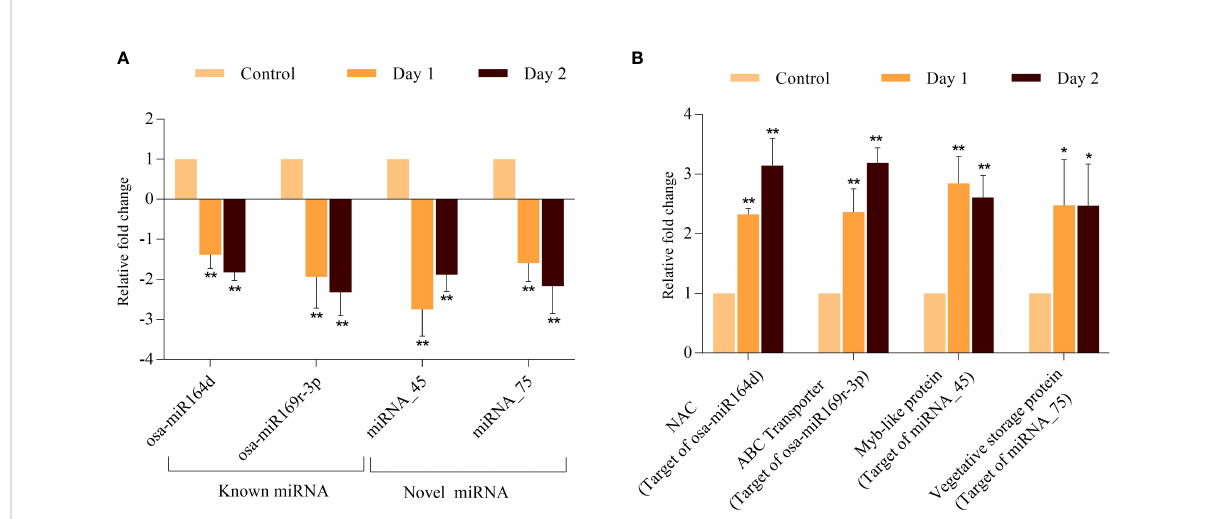
FIGURE 7 Validation of expression pro fi le of miRNAs and their predicted target genes during coleoptile senescence in rice. Expression analysis of selected miRNAs (A) and one of their predicted targets genes (B) using qPCR. For normalization of real-time PCR results, eEF-1 a was used as internal control. Three biological replicates and two technical replicates were included in the study. Asterisks indicate signi fi cant differences between the control and the senescence sample (Student ’ s t -test, * P < 0.05, ** P <